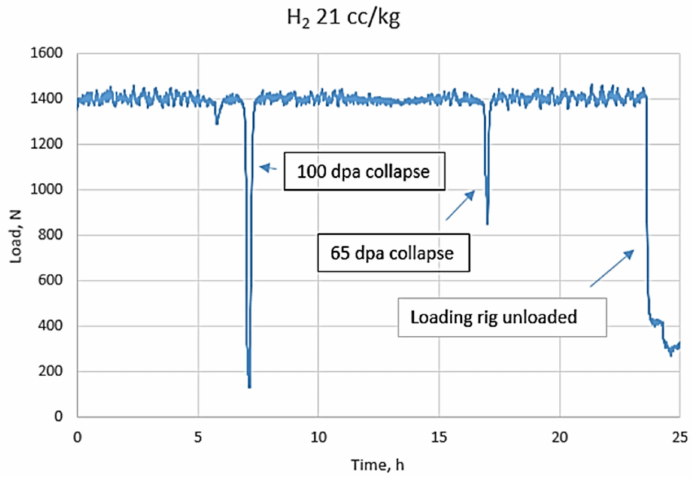
Figure 22. Applied load during the test in PWR water with lower dissolved hydrogen level (21 cc/kg).